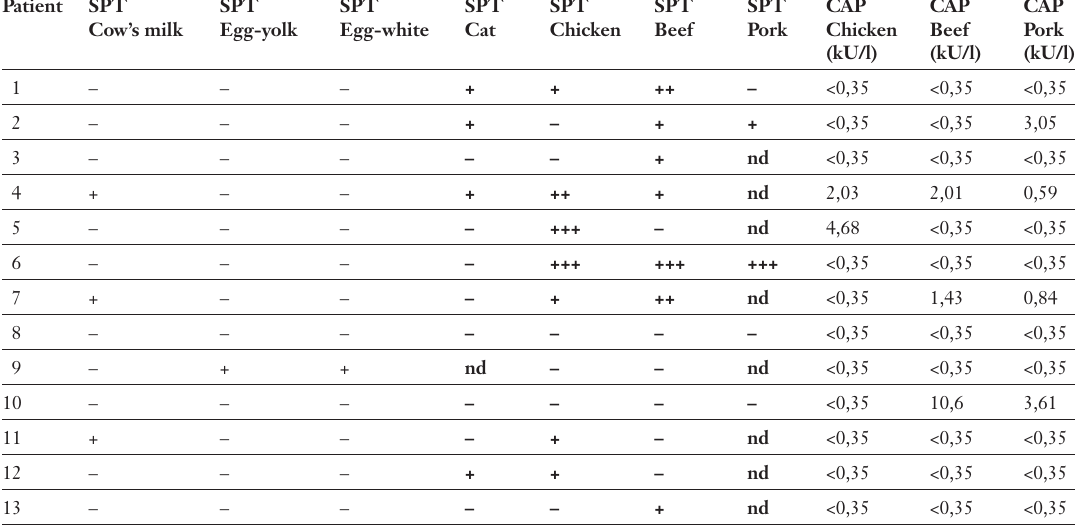
Skin-Prick-Test results with extracts from cow’s milk, egg-yolk, egg-white, cat, chicken-, beef-, pork- meat and CAP deter- mination of specific serum IgE to chicken, beef and pork